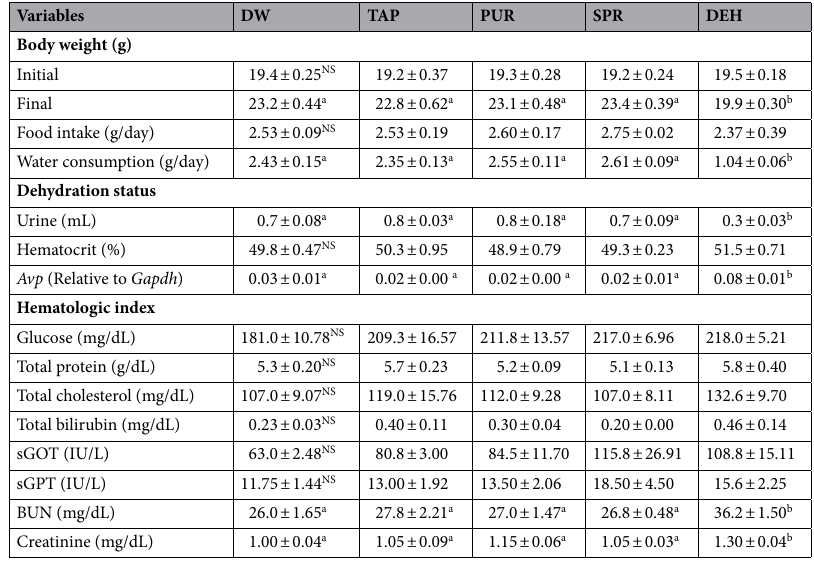
Table 1. Growth, dehydration status, and hematological index of the experimental groups by water source. BUN blood urea nitrogen, DEH dehydration, DW distilled water, NS not significant, PUR purified water,